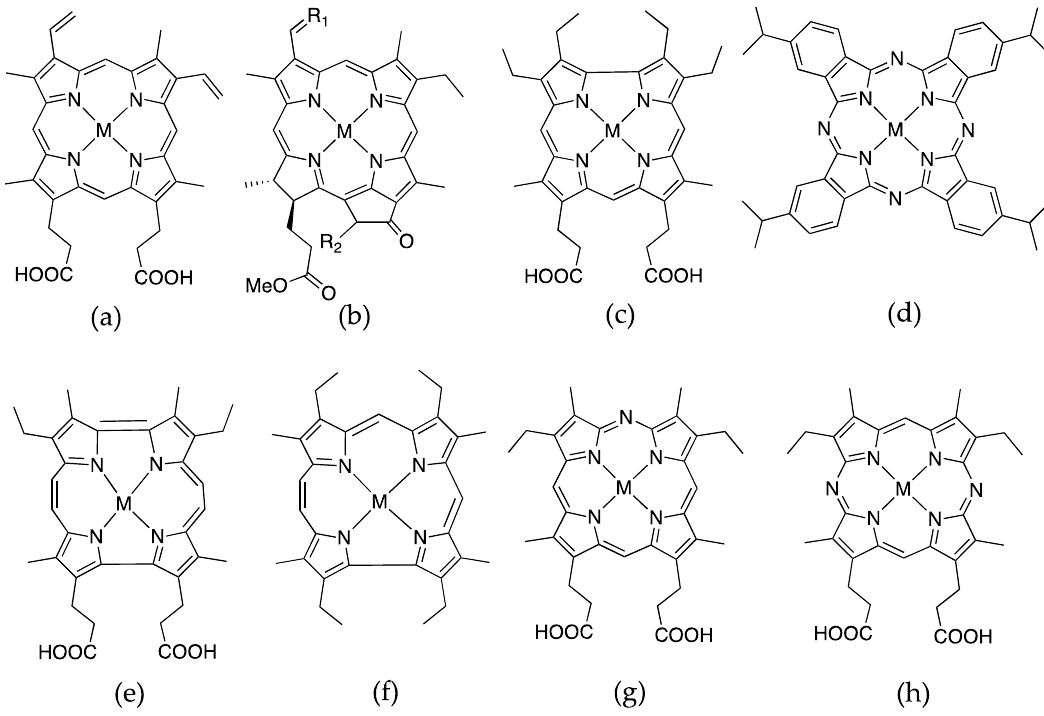
Figure 8. Porphyrin and porphyrin derivatives that have been successfully substituted into apohemoproteins, where M = Fe, Co, Cr, or Mn: ( a ) protopophyrin IX; ( b ) chlorin; ( c ) corrole; ( d ) phthalocyanine; ( e ) porphycene; ( f ) hemiporphycene; ( g ) monoazahemin; ( h )